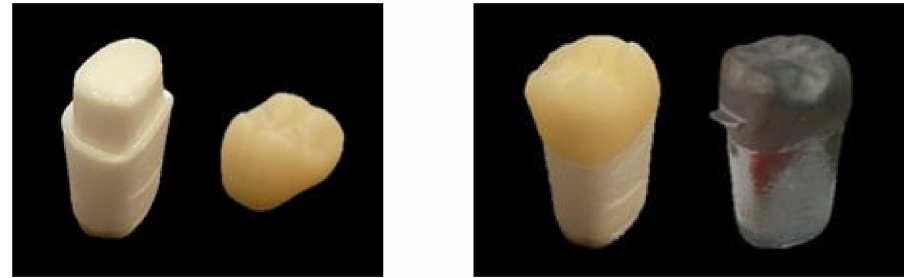
Figure 1. Plastic tooth of first maxillary molar with crown (zirconia reinforced lithium silicate) before and after gold coating.